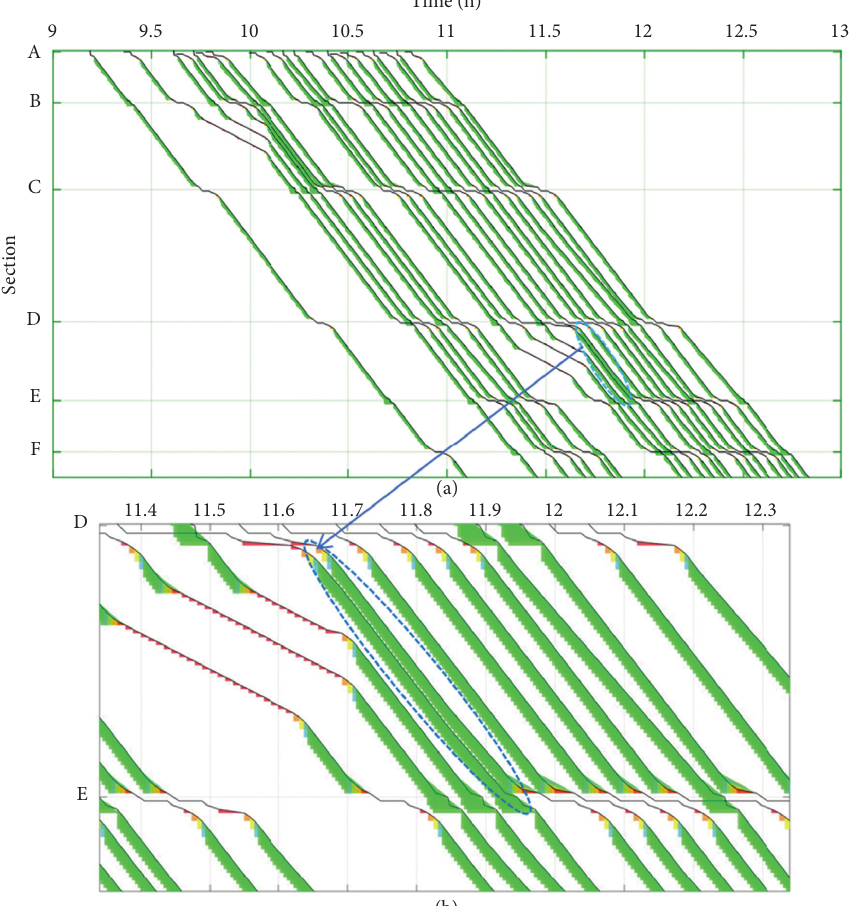
Figure 12: Rescheduled timetables after the second-step